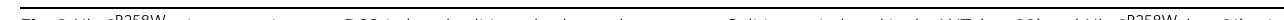
Fig. 2 Nlrp3 R258W mice are resistant to DSS-induced colitis and colorectal cancer. a – c Colitis was induced in the WT ( n = 32) and Nlrp3 R258W ( n = 21) mice using 2.5% DSS. The body weights ( a change in percentage), survival rates ( b change in percentage), and disease scores ( c arbitrary unit) were assessed daily. d The colon lengths were measured from the cecum – colon junction to the anus end of a loosely stretched colon with a straight ruler upon killing of indicated experimental mice on day 8 and representative examples are shown. e Hematoxylin and eosin (H&E)-stained transverse sections of the colons were examined and scored as described in the “ Methods ” section. Representative images of these samples are shown; the scale bar is 200 µ m. f WT ( n = 6 for 3 days, n = 3 for 5 days) and Nlrp3 R258W ( n = 3 for 3 days, n = 3 for 5 days) mice were treated with 2.5% DSS in drinking water for indicated days, then they were gavaged with FITC-Dextran and leakage of FITC-Dextran into the serum was measured 4 h later. g The indicated cytokines or chemokines in the culture supernatants of colon tissues from mice as shown in d were determined via ELISA. h The indicated transcripts from colon tissue homogenates from mice as shown in d were analyzed by Q-PCR. AU arbitrary unit. i – l WT ( n = 10) and Nlrp3 R258W ( n = 11) mice were treated with AOM + DSS to induce colon cancer. The body weights ( i ) and survival rates ( j ) were monitored. The fi nal tumor loads ( k ) were shown as representative images, and the tumor size distributions ( l ) were determined. The data are shown as the means ± SEM. * P < 0.05, ** P < 0.01, *** P < 0.001 (Two-tailed Student ’ s t test). Survival rate b , j difference is tested by Log-rank (Mantel – Cox) test, * P <